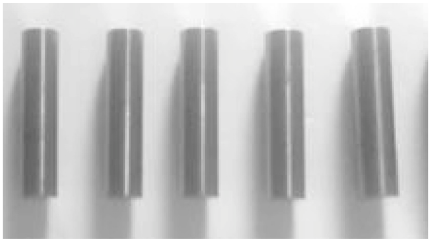
Figure 4: Specimens of the thermal